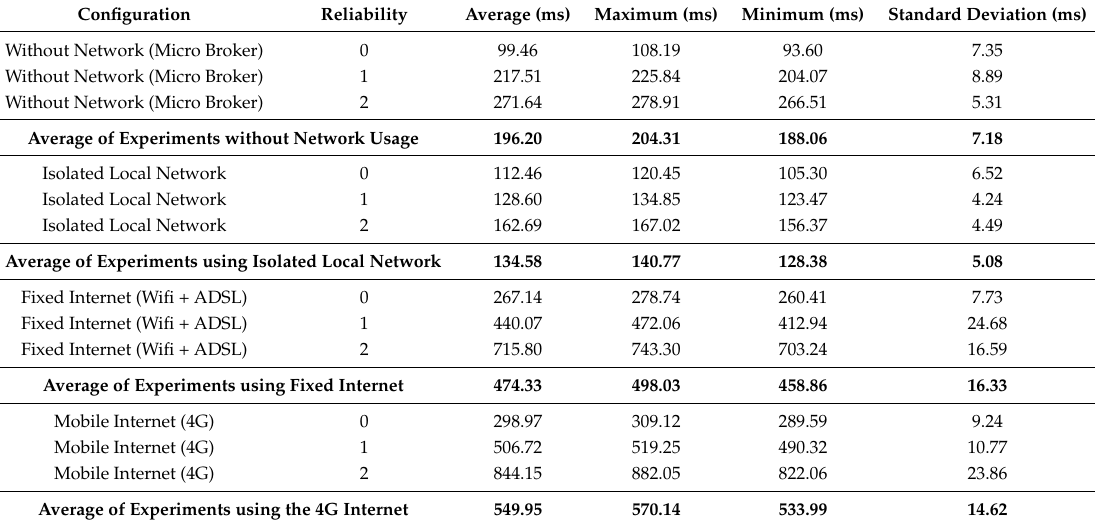
Table 4. Evaluation of the Distribution Service Performance in relation to the Total Time of Information Delivery to the